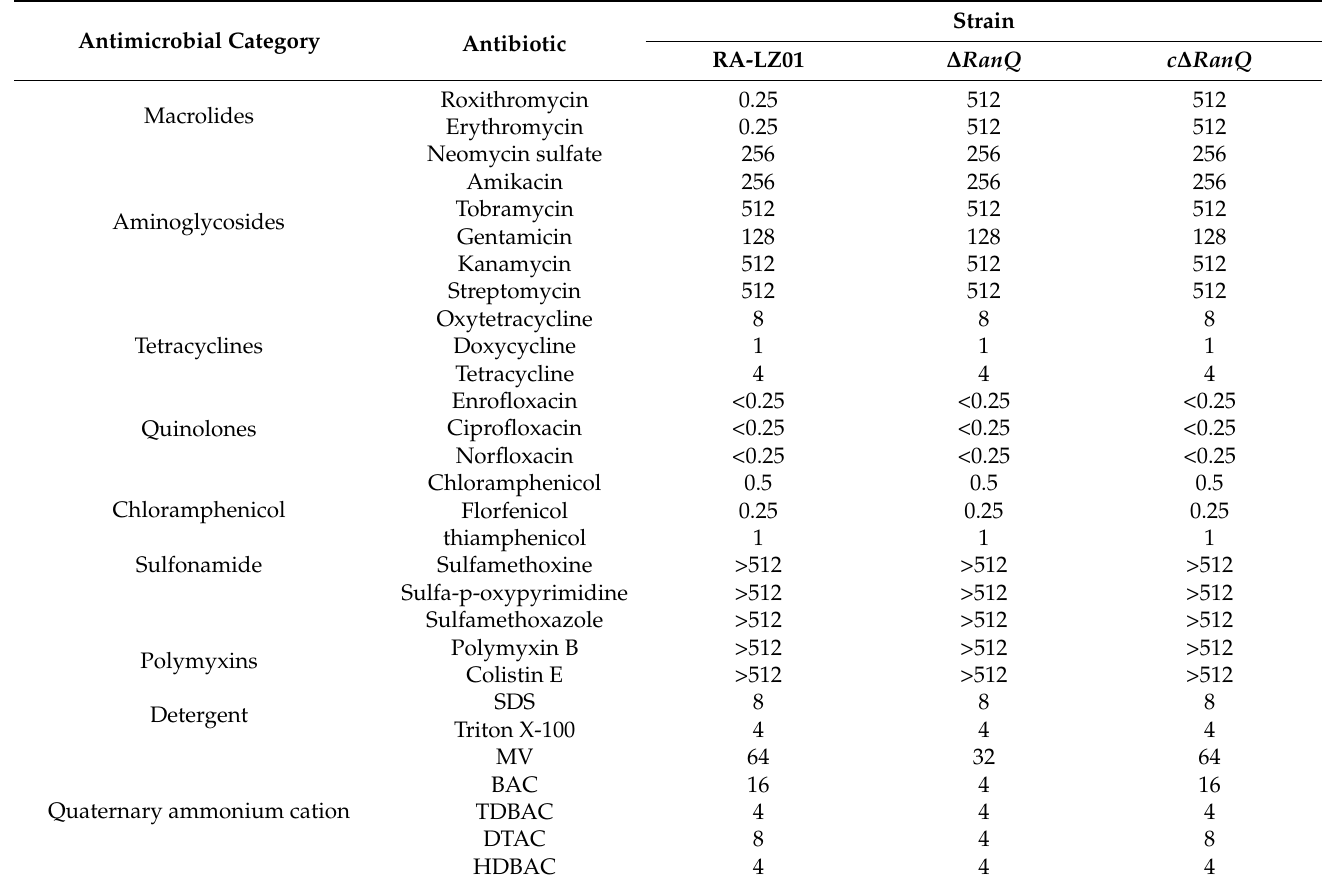
Table 3. An evaluation of MIC values for various antimicrobials in the presence of RA-LZ01, RA- LZ01 ∆ RanQ , and RA-LZ01c ∆ RanQ strains.